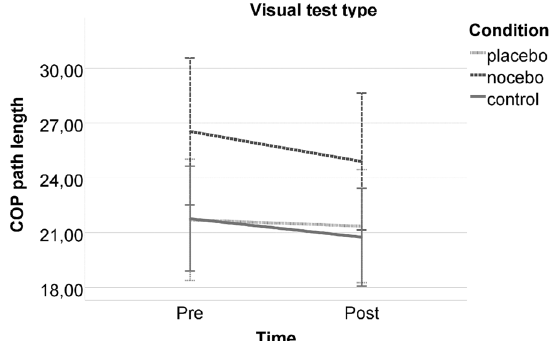
Fig. 4 Postural stability performance of the experimental groups pre- and post-intervention in the vision test type. Note: The error bars reflect 95% CI